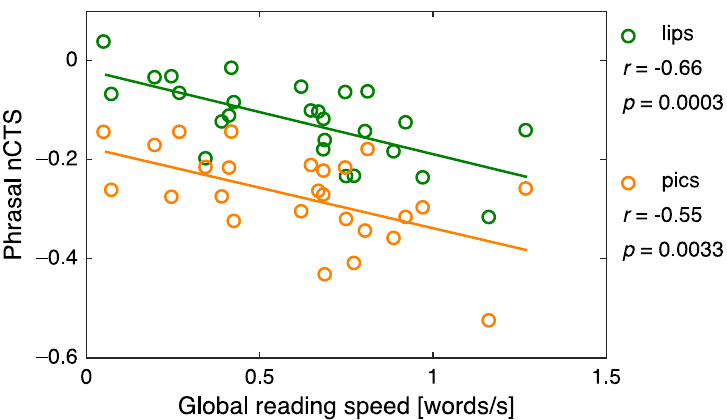
Fig 5. Relation between reading speed and the nCTS at phrasal rate in dyslexia. On the x-axis is the mean of the four reading scores indexing reading speed: reading score for irregular, regular, and pseudowords and Alouette reading speed (converted to a number of words read per second). On the y-axis is the mean nCTS across babble noise conditions and both hemispheres for the two types of visual input: pics (orange) and lips (green). Circles depict participants’ values, and full traces are the regression lines. Correlation and significance level are indicated on the right. S5 Data contains the underlying data for this figure. nCTS, normalized cortical tracking of speech.